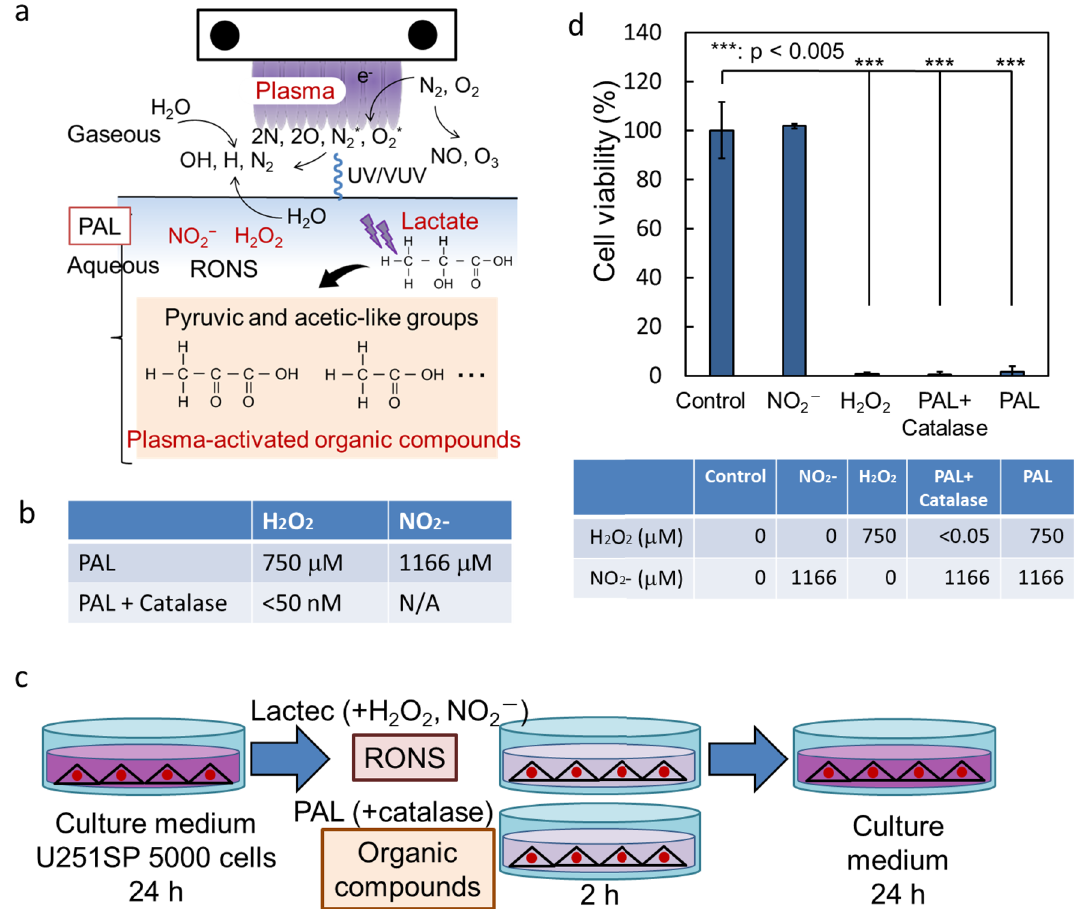
Figure 1. The effect of RONS in PAL. ( a ) Schematic of the chemical components in Plasma-activated Ringer’s lactate solution (PAL). ( b ) Concentrations of hydrogen peroxide and nitrite in PAL with and without catalase. ( c ) Experimental procedure to measure the cytotoxicity of Reactive oxygen and nitrogen species (RONS) and PAL with and without catalase. ( d ) Cytotoxic effects of RONS in PAL. Lactec: Ringer’s lactate